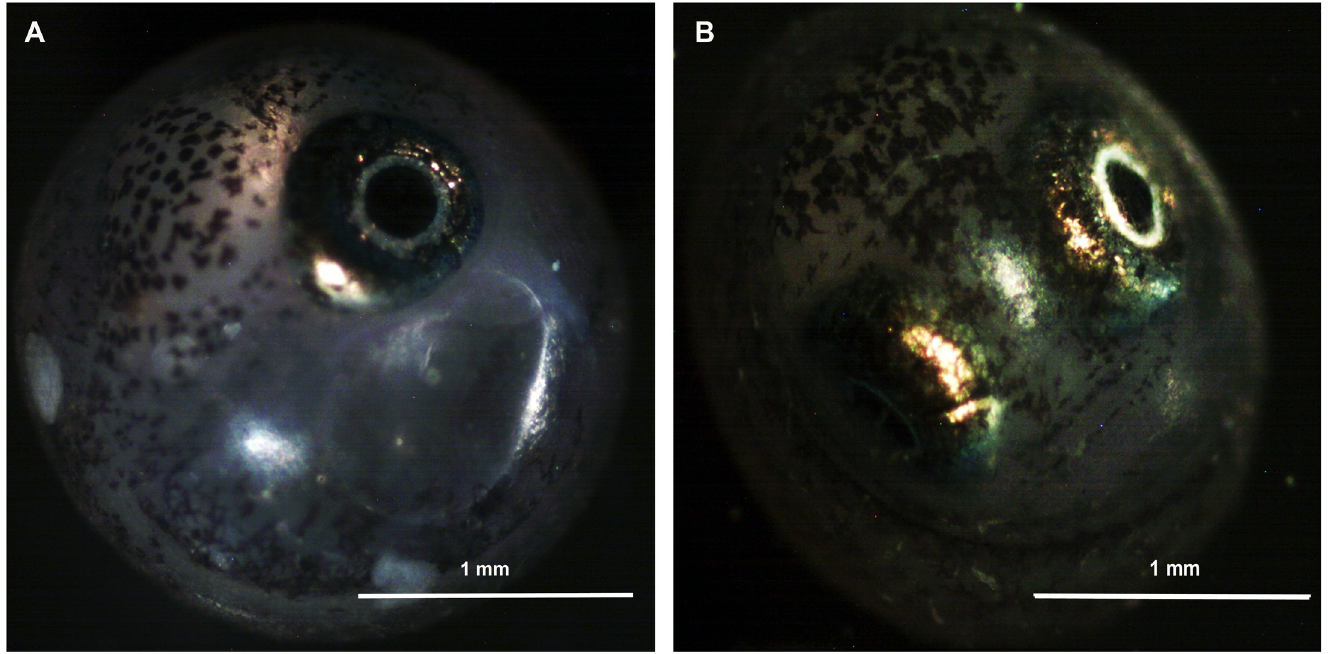
Fig 1. Austrolebias charrua embryos. A) Prehatching (PRE) (stage 41 [2]), B) diapause III (DIA) (stage 43 [2]).